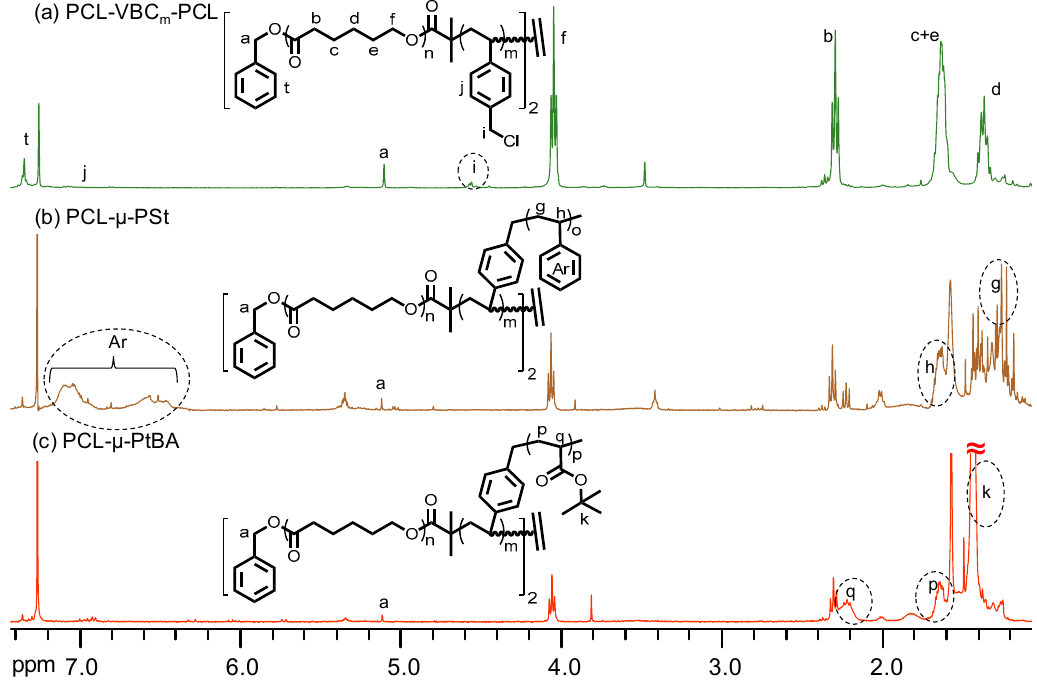
Figure 6. 1 H NMR spectra (400 MHz, CDCl 3 ) of ( a ) PCL-VBC m -PCL, ( b ) PCL- µ -PSt, and ( c ) PCL- µ -PtBA (co)polymers.